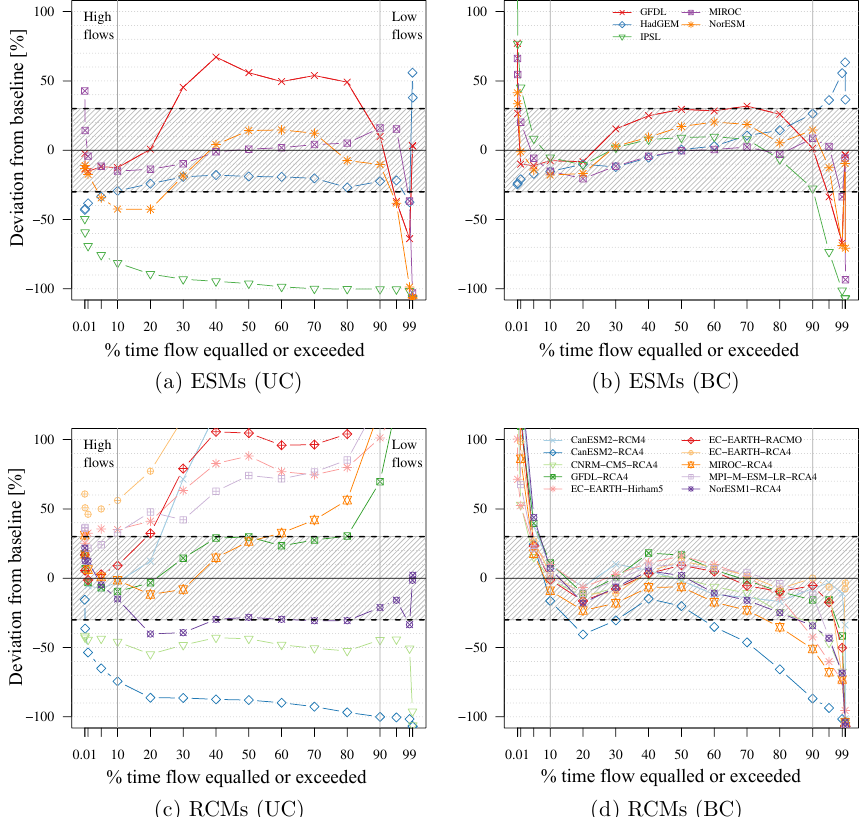
Figure 6. Relative deviations of FDCs from baseline discharge simulation at gauge El Diem using WATCH Forcing Data (WFD) in the reference period (1970–1999). Simulations based on uncorrected (UC) and bias-corrected (BC) Earth system model (ESM) input in the top row and regional climate model (RCM) input in the bottom